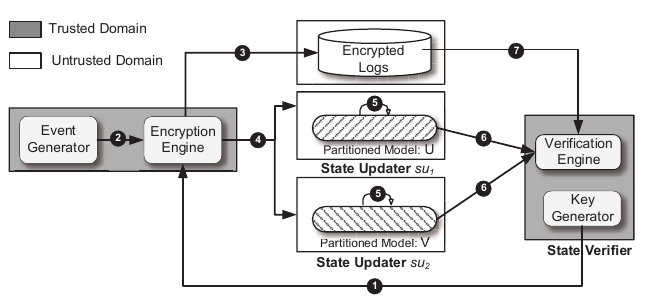
Figure 3. An Overview of VERDICT